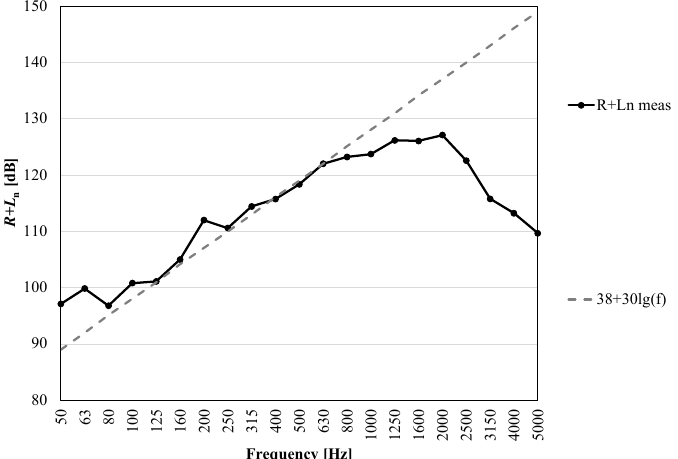
Figure 12. Measurements of normalized impact sound pressure level for the 200 mm CLT floor, comparison with R + 𝐿 (cid:3041) =38 + 30lg( f ) equation